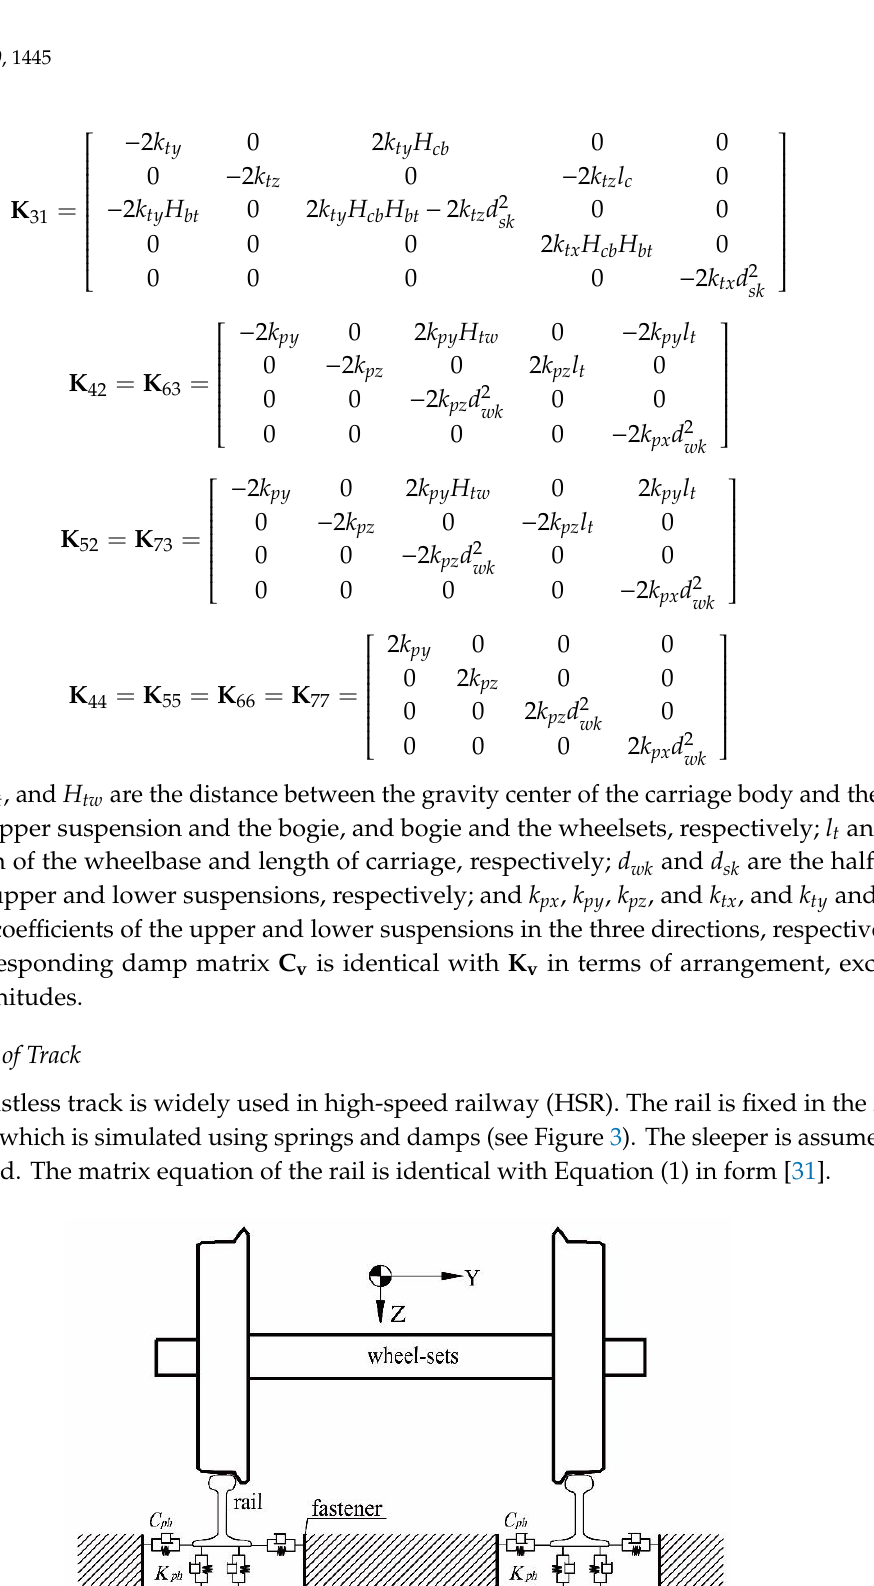
Figure 4. Schematic diagram of track irregularity.